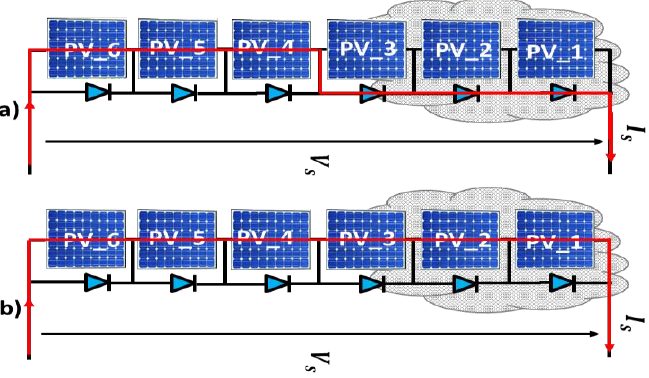
Figure 6. The current flow direction of the PV array ( a ) in area 1 and ( b ) in area 2.